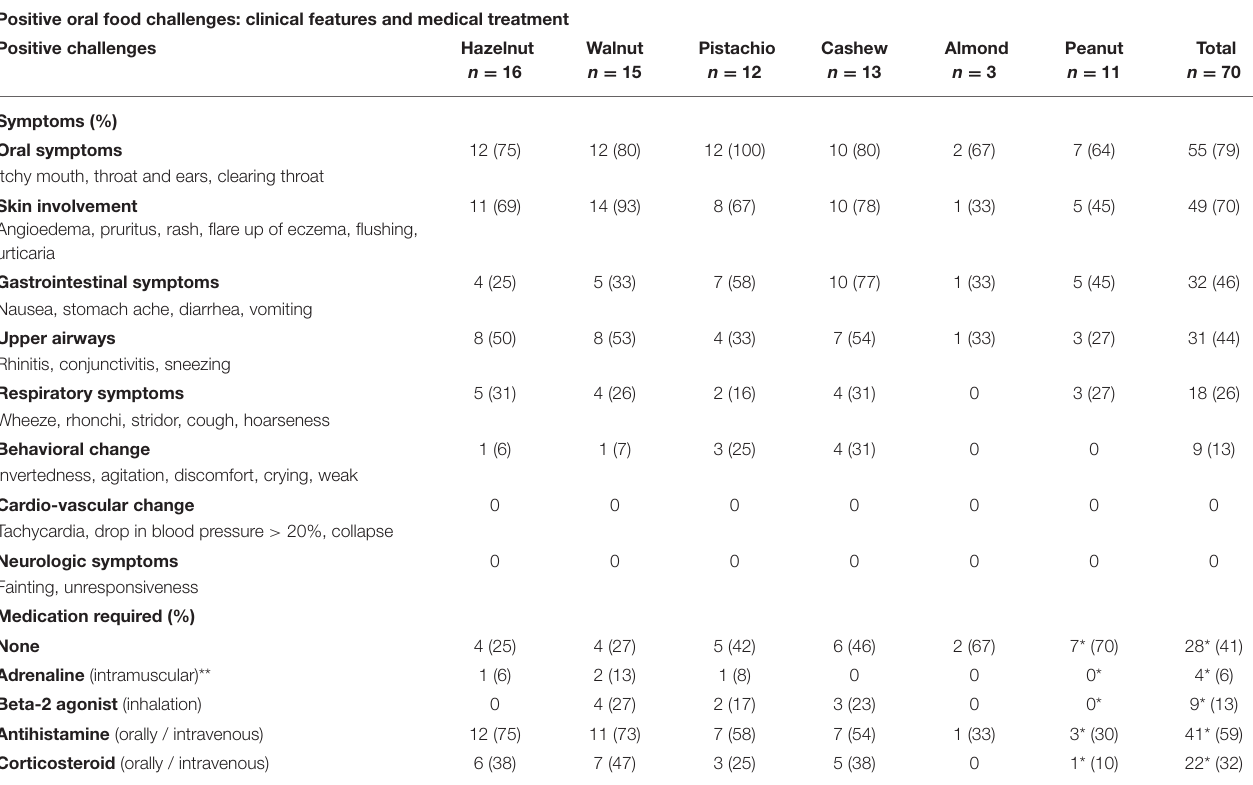
TABLE 3 | Positive oral food challenges: clinical features and medical treatment. Positive oral food challenges: clinical features and medical